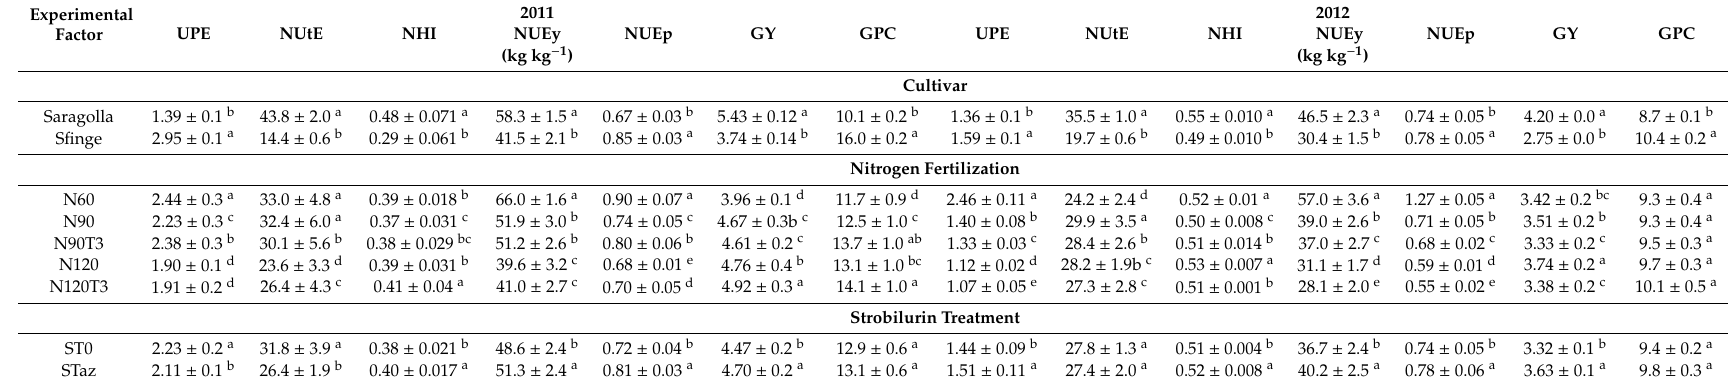
N60, N90 and N120 correspond to 60, 90 and 120 kg ha − 1 of nitrogen applied two times; N90T3, 90 kg ha − 1 of nitrogen applied three times; N120T3, 120 kg ha − 1 of nitrogen applied three times. ST0, no strobilurin treatment; STaz, strobilurin treatment. For each experimental factor, values in the column followed by di ff erent letters are significantly di ff erent at p ≤ 0.05 according to Tukey’s test. Data are reported as means ± standard